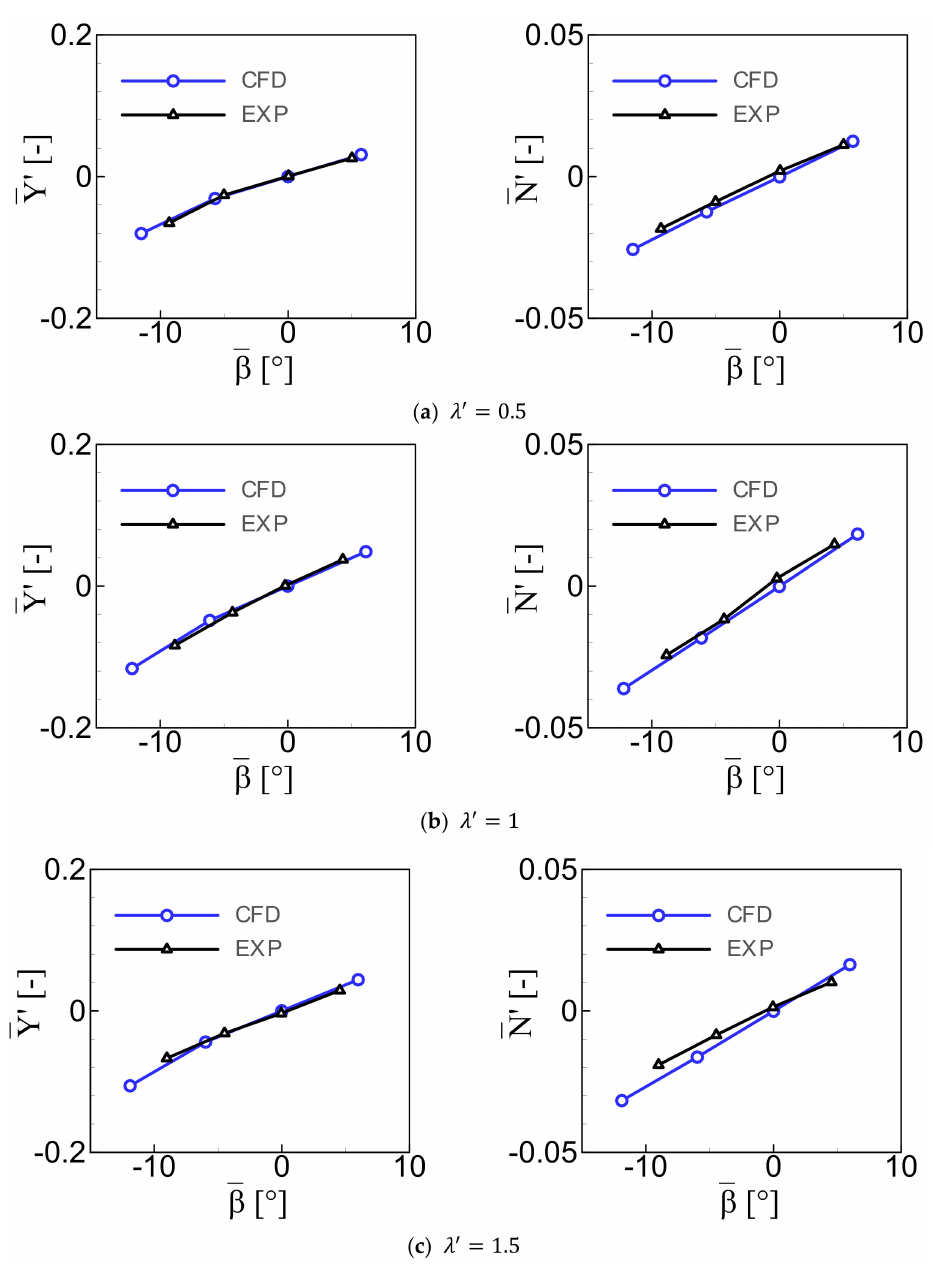
Figure 8. Mean sway force and yaw moment versus the mean oblique angle in head waves. The comparisons of the numerical added resistance and RAOs (Response Amplitude Operator) of surge, heave and pitch for β 0 = 0 ◦ in head waves with the experimental data are presented in Figure 9. The added resistance is computed by subtracting the calm-water resistance from the mean resistance with the contributions of the inertia effects in the waves, and is made non-dimensional by ρ gA 2 B 2 / L pp , where B is the ship breadth. For short waves, i.e., λ (cid:48) = 0.5, 0.7, the computed added resistances agree quite well with the experimental data. However, the added resistances for long waves are overestimated. Overestimation for surge RAOs is observed for long waves as well. Nevertheless, the computed RAOs of heave and pitch generally show fairly good agreements with the experimental data for both short and long